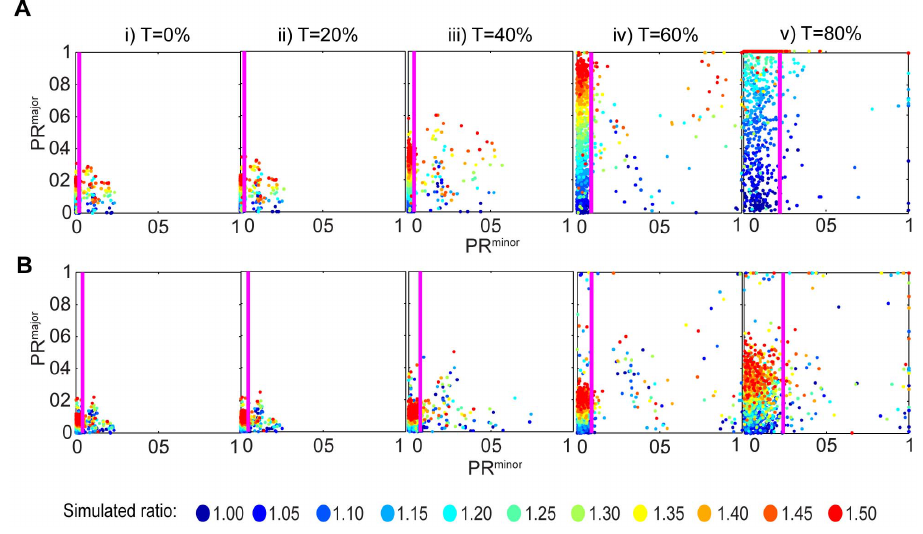
Figure 7. Sensitivity test from simulations. Cell divisions were simulated in increasing ratios from 1 to 1.5 with even increments of 0.05, giving n=1100 divisions in total. PR major was plotted against PR minor for non-clustered ( A ) and clustered ( B ) data. Data is showed as major/minor plot, under a range of thresholds from T=0%, to T=80% in increments of 20%. The magenta line shows gating exclusion of 10% of data with the highest PR minor . The gate shifts right as T value increase. The colours in the figure legend represent different ratios and corresponding to the ratio colour of each data dot. Input for simulations: h was chosen randomly varying from 0 to 90 degrees, distribution of parental radius and total intensity were selected randomly from a real distribution from real data, number of clusters in one of the daughter cells was 20 to 100, and the number of clusters in the other daughter cell was multiplied in the simulated ratio giving a possible range from 30 to 150.